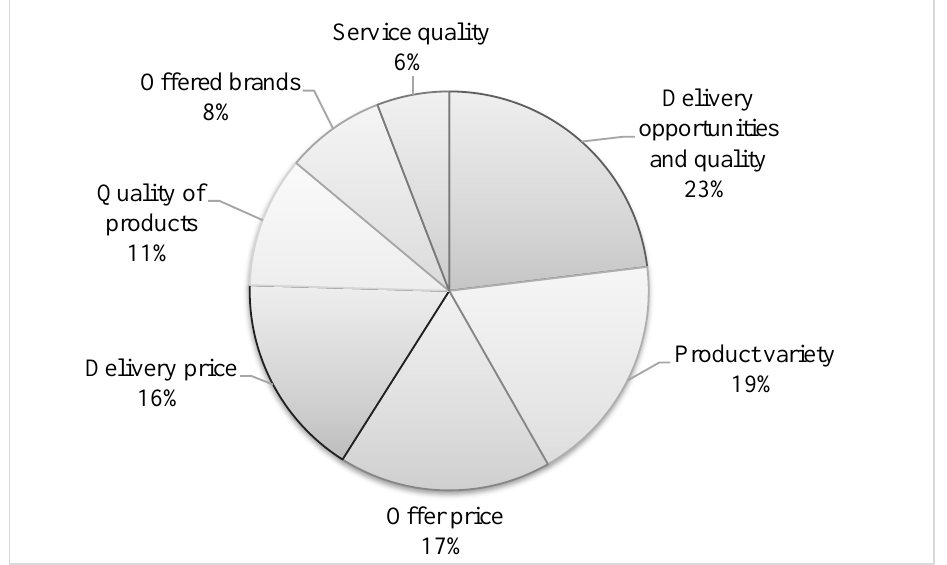
Fig. 3. Factors for